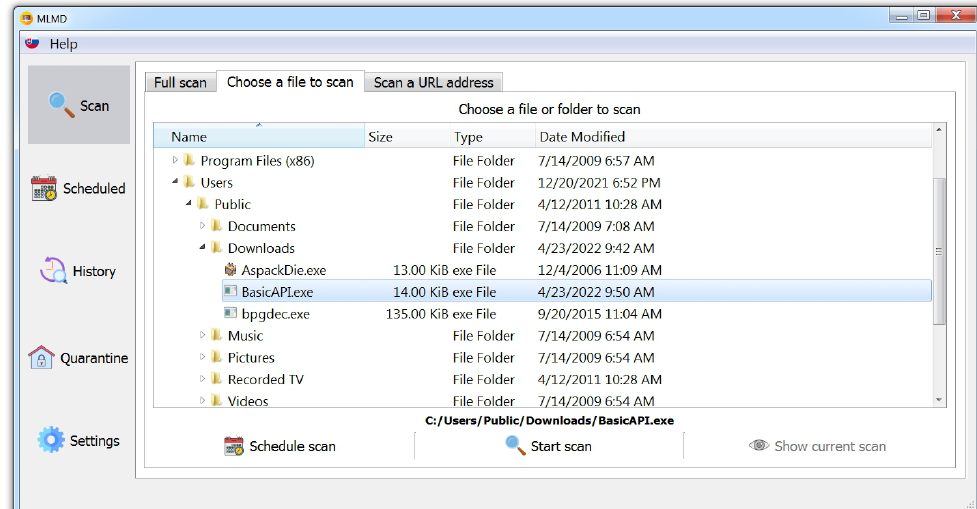
Figure 6. The main screen of the program.